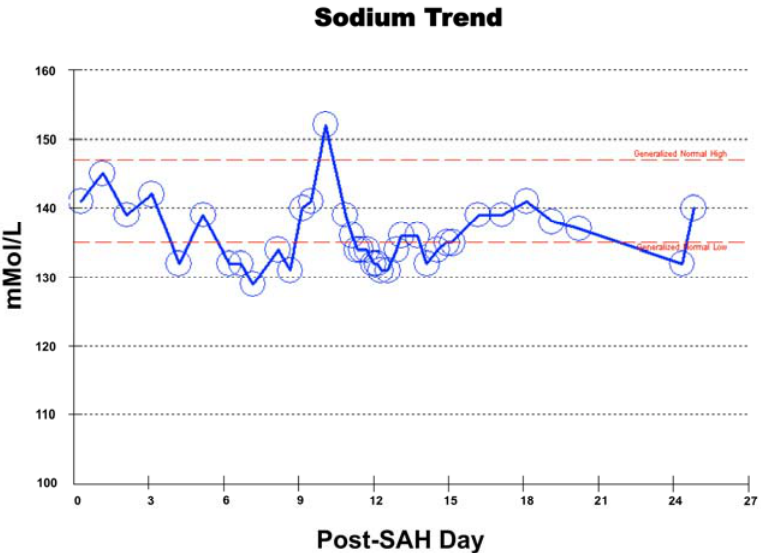
Figure 3. Serum sodium levels following subarachnoid hemorrhage (SAH) from presentation through 3.5 weeks post-hemorrhage in a 79-year-old woman with rupture